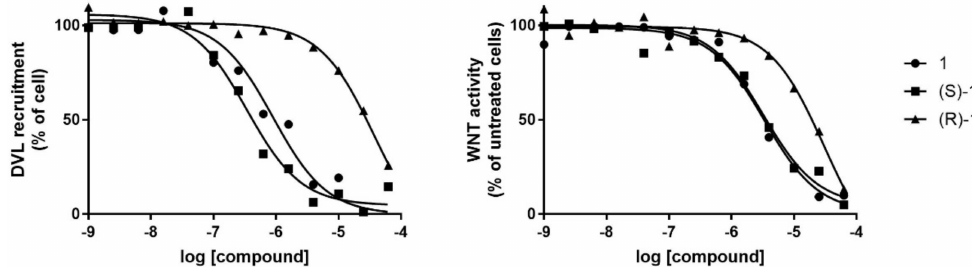
Figure 4. The dose response curves are representative for DVL recruitment inhibition experiment ( left panel) and WNT pathway activity measurement ( right